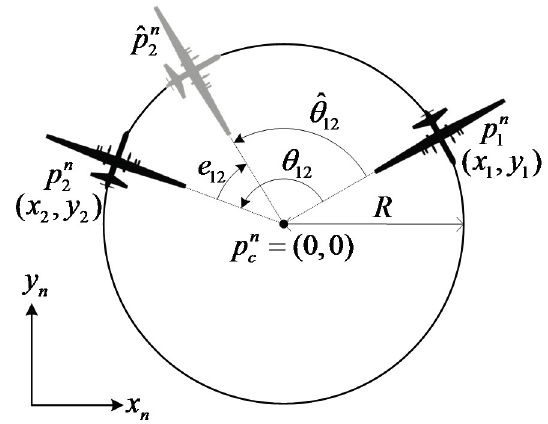
Figure 10. Phase angle on a circular